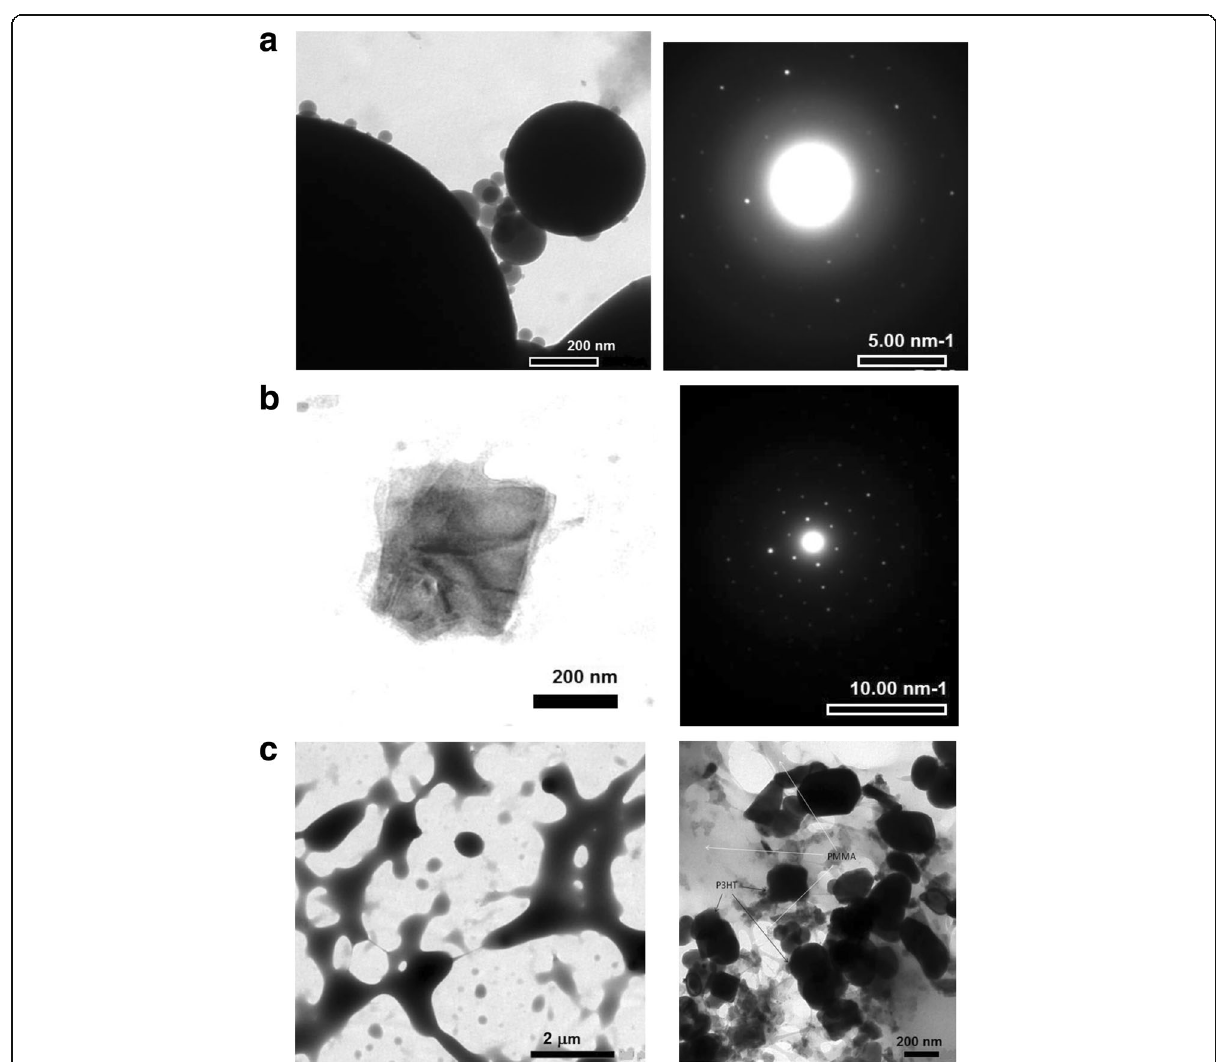
Fig. 5 TEM images of a spherical particles of P3HT, b crystalline domain of P3HT, and their corresponding SAED patterns to the right of the images; c neat PMMA ( right image ) and P3HT-PMMA blend ( left image ) are given for